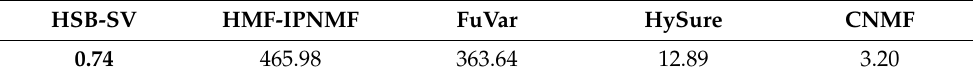
Table 6. Time processing of the tested methods (in seconds) for the synthetic dataset.